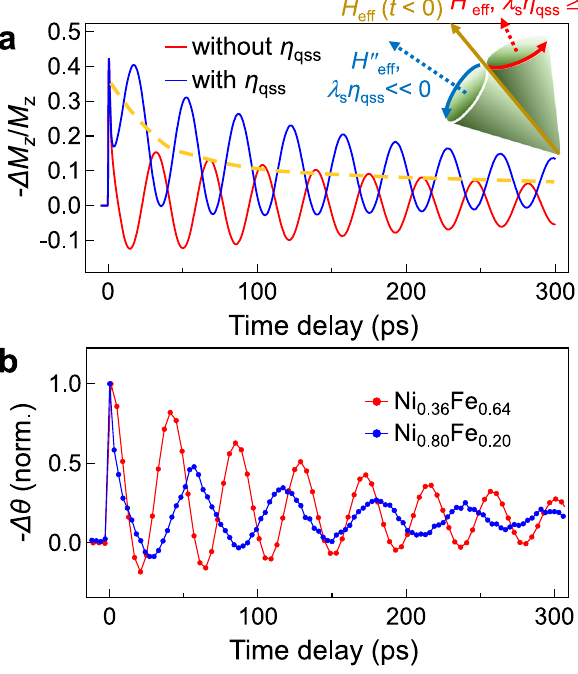
Fig. 4 Quasi-static strain (QSS) effect governing spin dynamics. a Calculated curves of spin dynamics based on the Landau – Lifshitz – Gilbert (LLG) equation for the absence (red) and presence (blue curve) of η qss under H = 0.54T and φ = 60°. The π -phase inversion is clearly observed around ext 20ps. The yellow dashed curve marks the monotonic-decaying background originated by a coherent rotation of H eff ( t ) to the in-plane direction. Inset: schematic diagram describing the rotation direction of H eff ( t ) depending on either QSS (blue) or thermal effect (red). b Experimental veri fi cation of the π - phase inversion of the spin precession for materials with negligible magnetoelastic energy (Ni 0.36 Fe 0.64 (red): the thermal expansion coef fi cient Fig. 3 Ferromagnetic resonance frequency with the control parameters T , β ~0, φ , and η f r qss . Contour maps of a ferromagnetic resonance frequency calculated using the classical Kittel equation as a function of temperature T and magnetic fi eld angle φ under H ext = 0.4 T, for the absence ( a for Co) and presence ( b for Co and c for Ni) of η qss , respectively. The f r decreases monotonically with increasing T for case a , but increases moderately showing the in fl ection point around 800 K for case b , implying competition between the thermal and strain effects. The shaded boxes in b stand for the domains where f r increases (blue) and starts to slow down (red) as T increases. d Selected curves of Δ f/f m at φ = 25, 45, and 60° from c . e Δ θ ( t )/ θ of Ni(270)/SiO H = 0.4 T and φ = 25° as a function of I 2 under ext p . Unlike the Co bilayer, the sign of Δ f/f m changes, as shown in the inset, con fi rming the competition between the thermal and the quasi-static strain (QSS) effects. All data points in the inset are presented with error bars obtained from the least-square fi t.